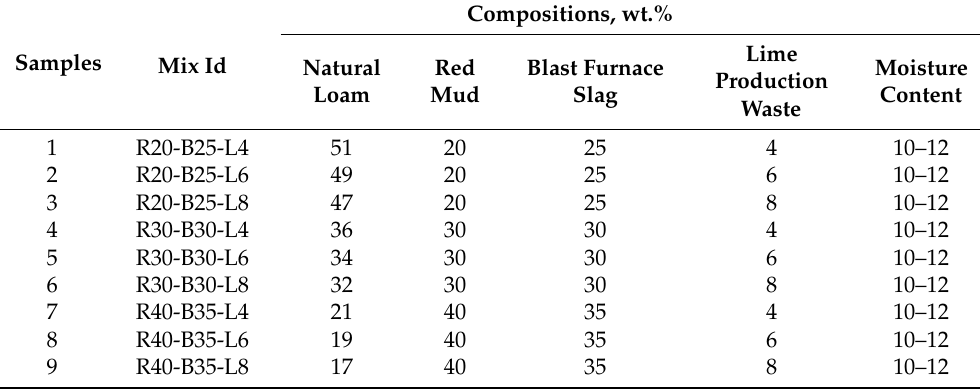
Figure 2. Details of specimen preparation: ( a ) tools used for compaction; ( b ) appearance of com- pacted specimens.